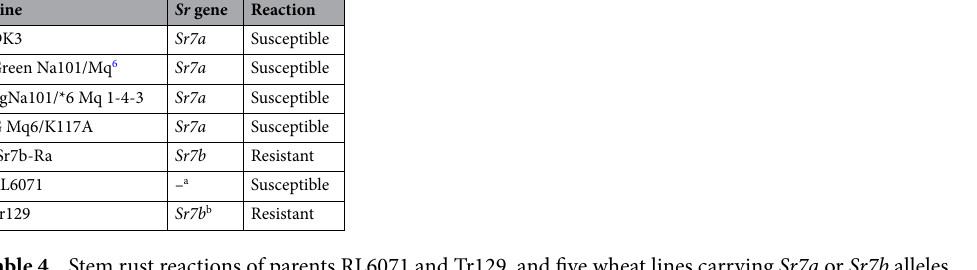
Table 4. Stem rust reactions of parents RL6071 and Tr129, and five wheat lines carrying Sr7a or Sr7b alleles when tested with Pgt race C. a No effective Sr gene present against race C. b